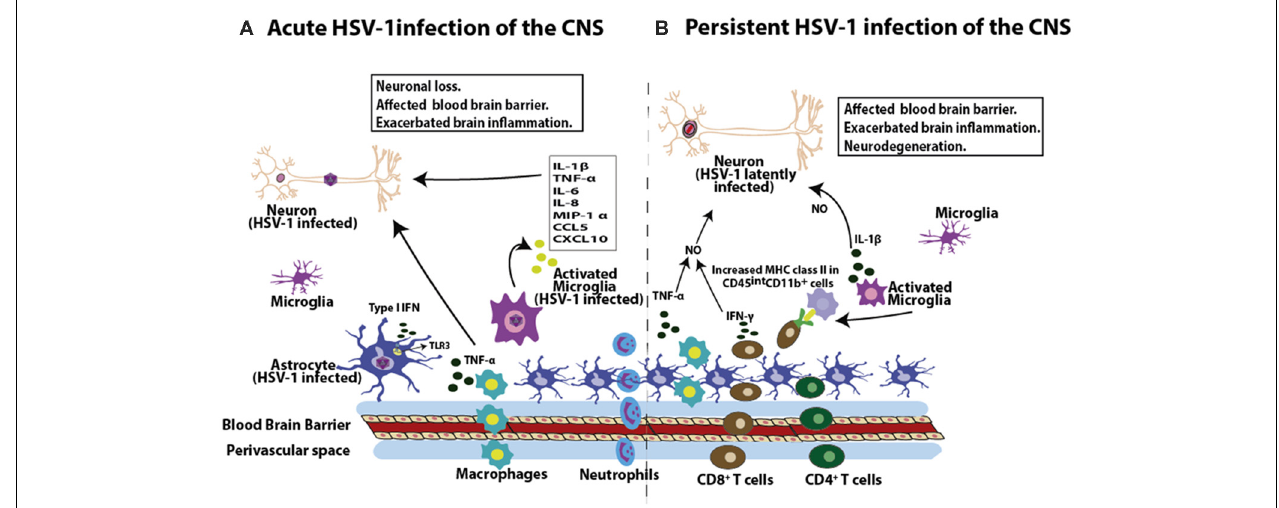
FIGURE 3 | HSV-1 induces inflammation in the brain. (A) During acute infection of the brain, HSV-1 leads to the infiltration of macrophages and neutrophils. Moreover, HSV-1 infection induces the expression of pro-inflammatory molecules in this tissue, such as interleukin-1 β (IL-1 β ), tumor necrosis factor- α (TNF- α ), IL-6, IL-8, macrophage inflammatory protein 1- α (MIP-1 α ), chemokine (C-C motif) ligand 5 (CCL5) and chemokine CXCL10 by microglial cells, as well as TNF- α production by macrophages. Astrocytes in turn produce type-I interferon (IFN) mediated by TLR3 engagement in response to HSV-1. These soluble molecules will affect the permeability properties of the blood brain barrier (BBB) and potentially exacerbate brain inflammation, potentially leading to neuron insult. (B) HSV-1 latent CNS infection is characterized by the infiltration of CD8 + and CD4 + T cells. Importantly, these T cells are localized near latently infected neurons and are detected in a 3:1 ratio (CD8 + to CD4 + T cells). Moreover, CD8 + T cells can secrete IFN- γ . Prolonged microglial activation in the brain by HSV-1 infection produces increased MHC-II expression in CD45 int CD11b + cells, which lasts up to 30 days post-infection. As a consequence of immune cell infiltration into the brain during both,